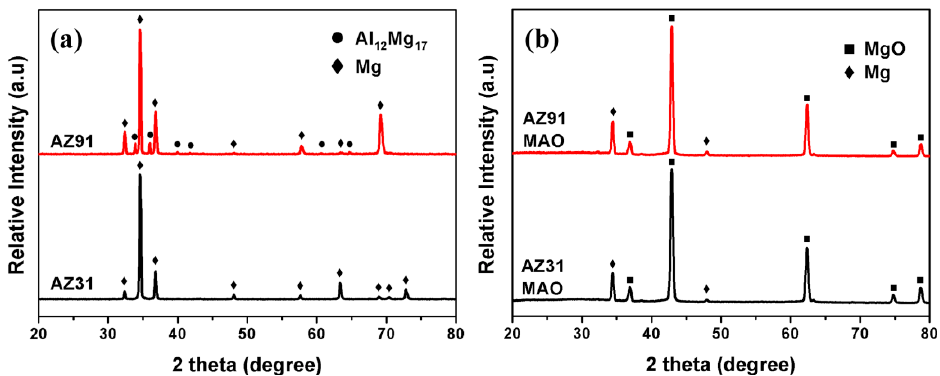
Figure 3. ( a ) XRD patterns of the uncoated AZ31 and AZ91 Mg alloys; ( b ) XRD patterns of the MAO treated AZ31 and AZ91 Mg alloys.